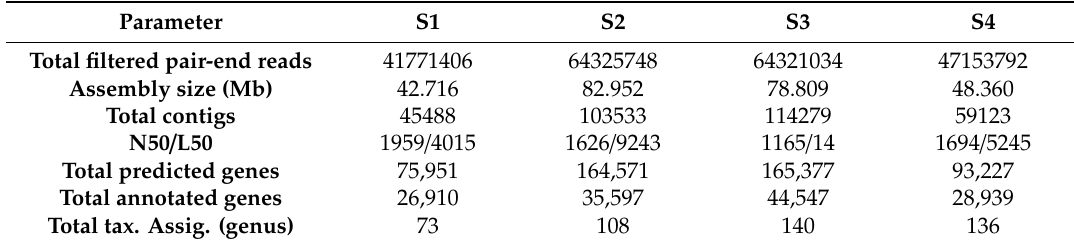
Table 2. Summary of the metagenomic and bioinformatic analysis.